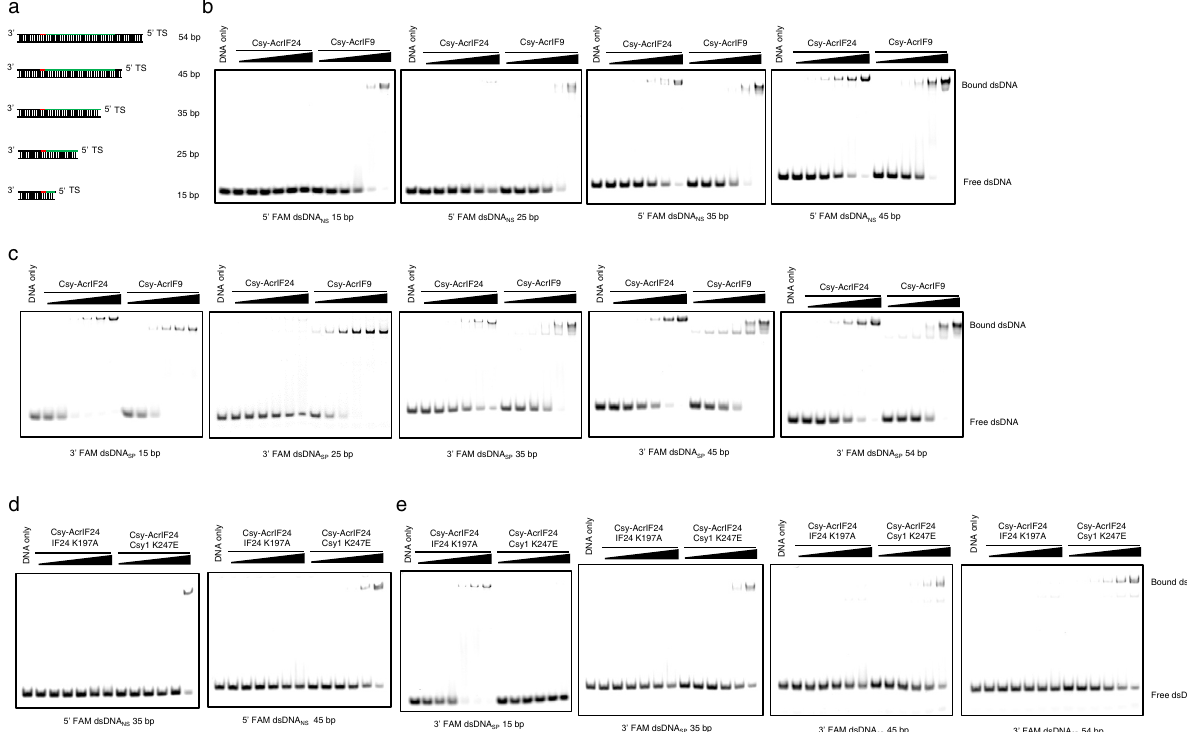
Fig. 8 The Csy-AcrIF24 complex interacts with dsDNA SP and dsDNA NS through similar mechanisms. a Schematic illustration of the dsDNA SP with different lengths is used in the present study. Red and green lines represent PAM and protospacer sequences, respectively. b – c EMSA was used to test the non-speci fi c DNA binding of Csy-AcrIF24 or Csy-AcrIF9 using dsDNA NS with 5 ′ FAM labels ( b ) and dsDNA SP with 3 ′ FAM labels ( c ) of different lengths. Reactions were performed as in Fig. 5c. d – e EMSA was used to test the non-speci fi c DNA binding of Csy-AcrIF24 mutants using dsDNA NS with 5 ′ FAM labels ( d ) and dsDNA SP with 3 ′ FAM labels ( e ) of different lengths. Reactions were performed as in Fig. 5c. Please see the right two panels of b for WT controls of the experiments using dsDNA NS 35 bp and 45 bp in d ,